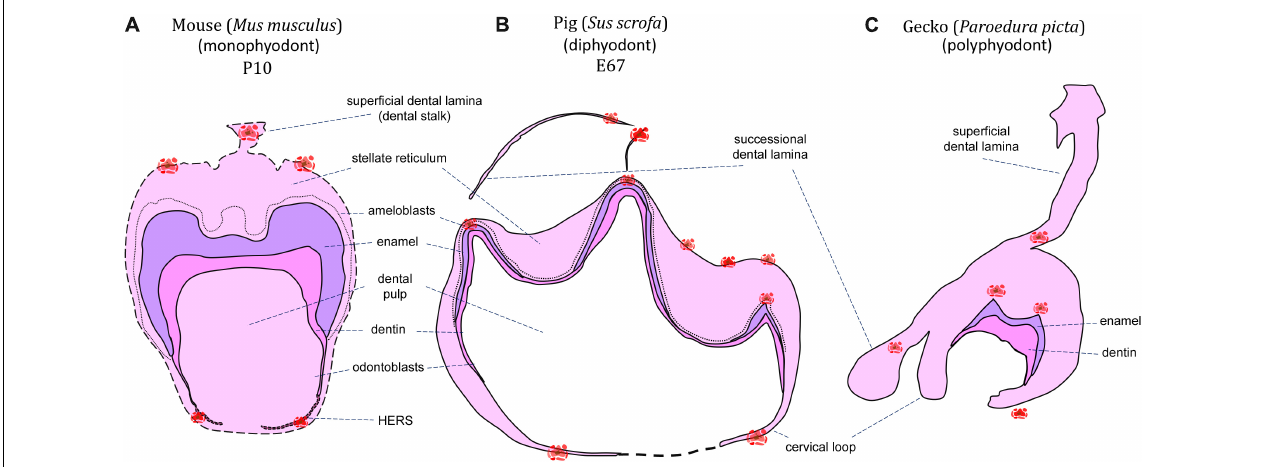
FIGURE 1 | Schematic of apoptotic cells distribution through mineralization stage of the tooth germ. Clusters of apoptotic bodies are labeled in red and label areas of possible future interest in monophyodont mouse (A) , diphyodont pig (B) , and polyphyodont gecko (C)